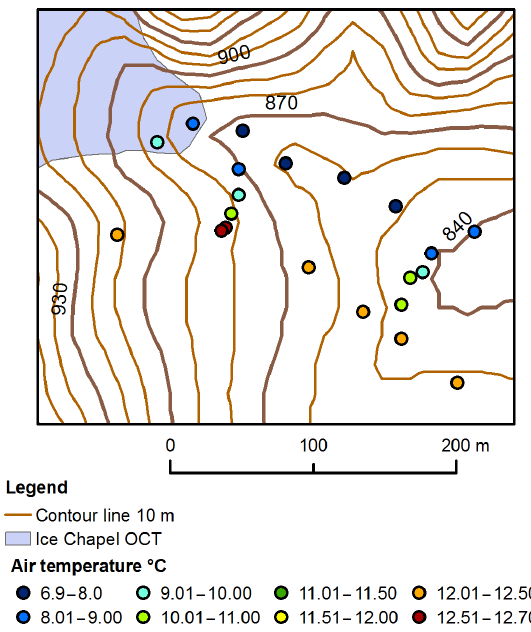
Figure 8. Air temperatures T A measured on 26 October 2017 with mobile meteorological stations at 2m above the